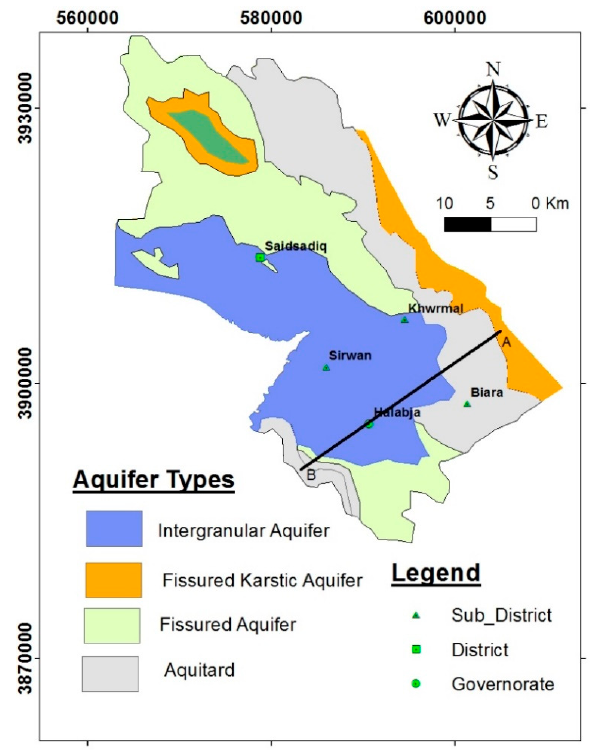
Figure 3. Hydrogeological map of the HSB, modified from [15,16].